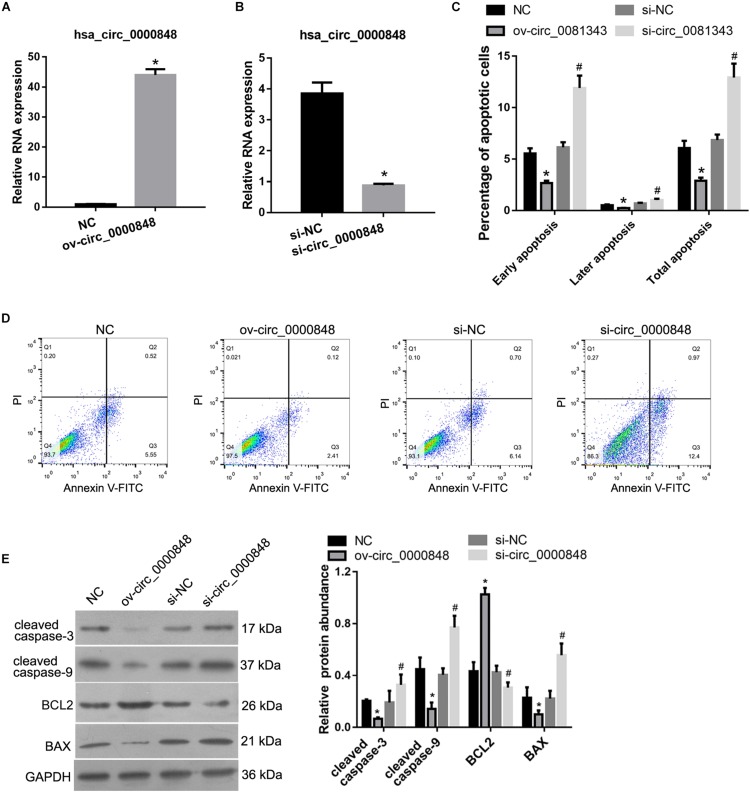
Effect of hsa_circ_0000848 overexpression or knockdown on apoptosis of HTR-8 cells. (A) hsa_circ_0000848 is overexpressed in HTR-8 cells after transfection with hsa_circ_0000848 containing plasmid (ov-circ_0000848) compared to negative control plasmid (NC). *P < 0.05, when compared to NC using unpaired t-tests. (B) hsa_circ_0000848 expression is lower in HTR-8 cells after transfection with siRNA targeting hsa_circ_0000848 (si-circ_0000848) compared to that in NC siRNA (si-NC). *P < 0.05, when compared to si-NC using unpaired t-tests. (C,D) Effect of hsa_circ_0000848 overexpression or knockdown on the apoptosis of HTR-8 cells. Panel C shows quantification of the percentage of apoptotic cells. Panel D shows representative graphs of the apoptosis detected using a flow cytometer. (E) Effect of hsa_circ_0000848 overexpression or knockdown on protein abundance of MMP-2 and MMP-9 in HTR-8 cells. The left panel includes representative images of western blots. The right panel graphs represent the quantification of relative protein abundance. *P < 0.05, when compared to NC using unpaired t-tests. #P < 0.05, when compared to si-NC using unpaired t-tests.